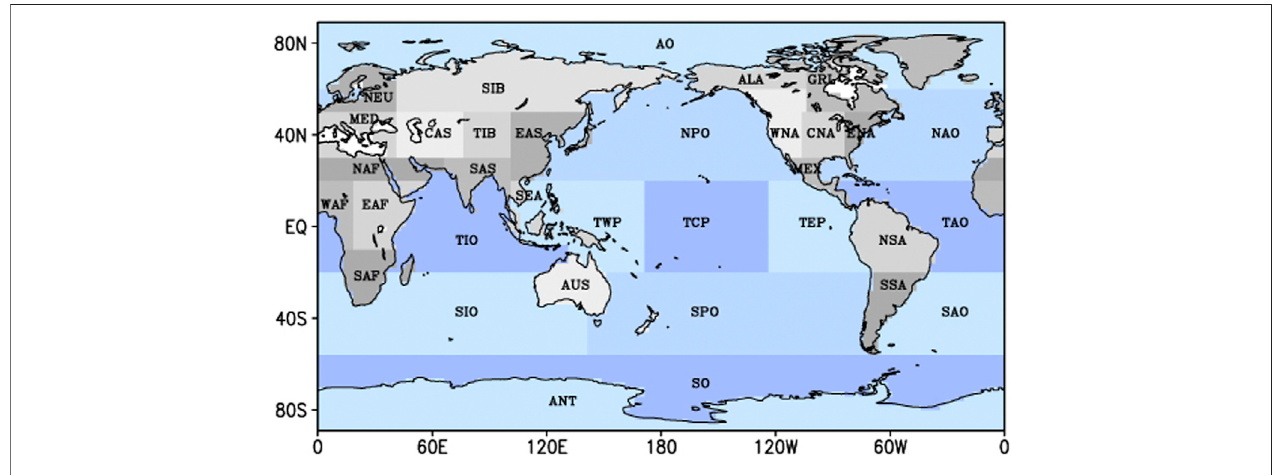
FIGURE 1 | Divisions of the